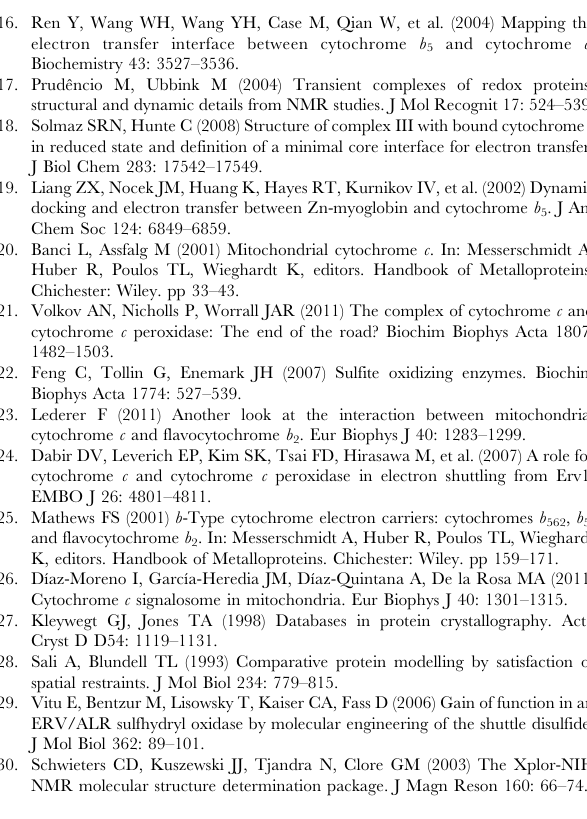
rates. For details, see the legend to Figure 3 in the main text.